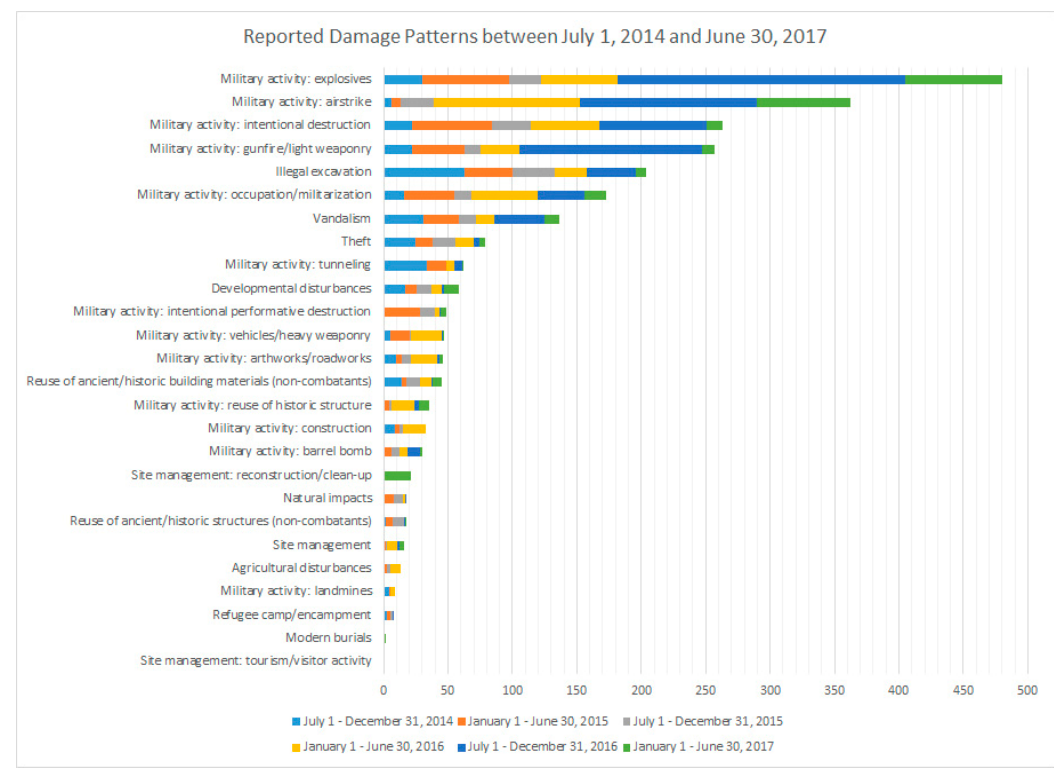
Figure 2. Damage patterns reported by CHI in the ongoing weekly and monthly report series since the project’s inception in 2014. The horizontal bars representing incident totals (horizontal axis) by causes of damage are subdivided (stacked) according to report dates rather than the date(s) that the incidents occurred, to account for those incidents currently without known dates (ASOR CHI; 26 July 2017).